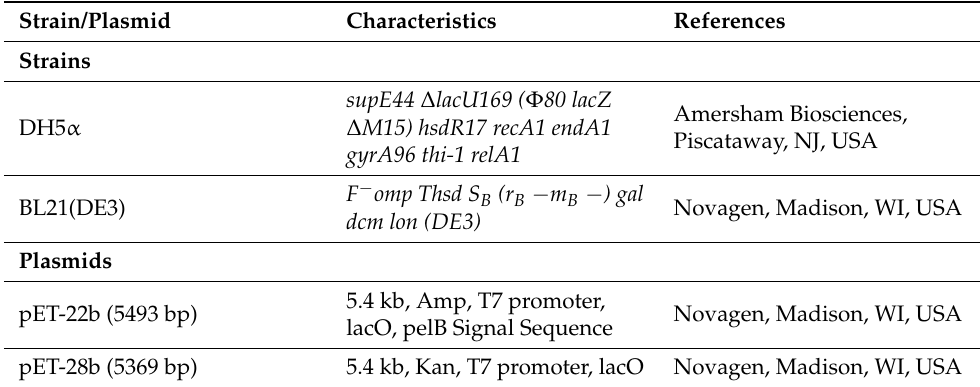
Table 1. Host strains and plasmids